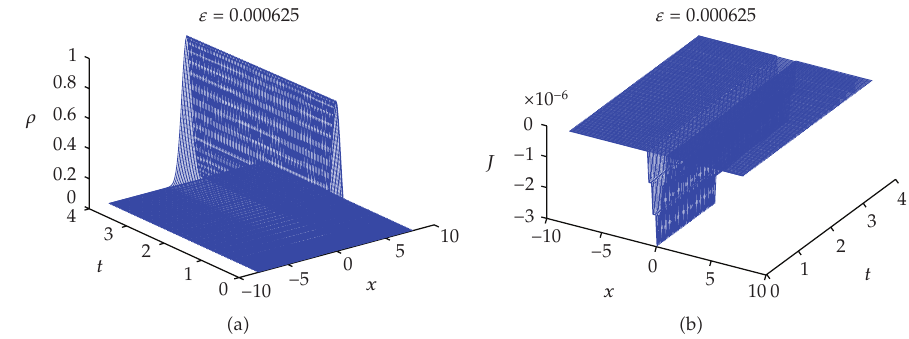
Figure 9: Numerical solutions of Example 5.2 by ED2/EP2 for the weak O (cid:3) ε 3 / 2 (cid:4) defocusing nonlinearity (cid:3) ε (cid:6) 0 . 000625 (cid:4)